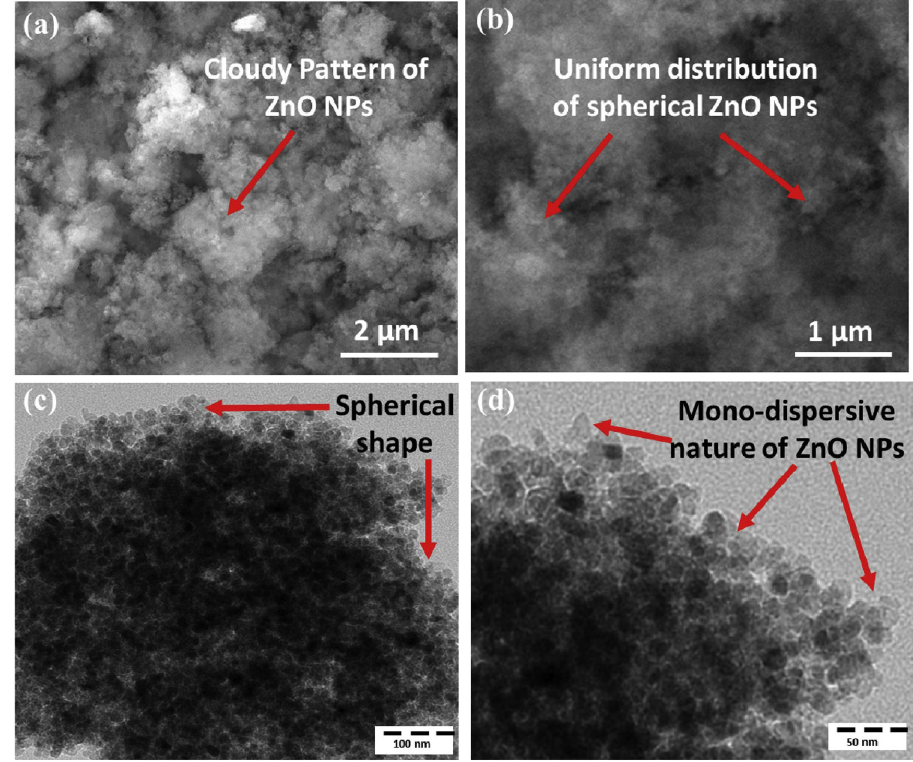
Figure 24: SEM ( a and b ) and TEM ( c and d ) for ZnO - NPs at di ff erent magni fi cations. Copied with permission from ref. [ 275 ] ; Elsevier,